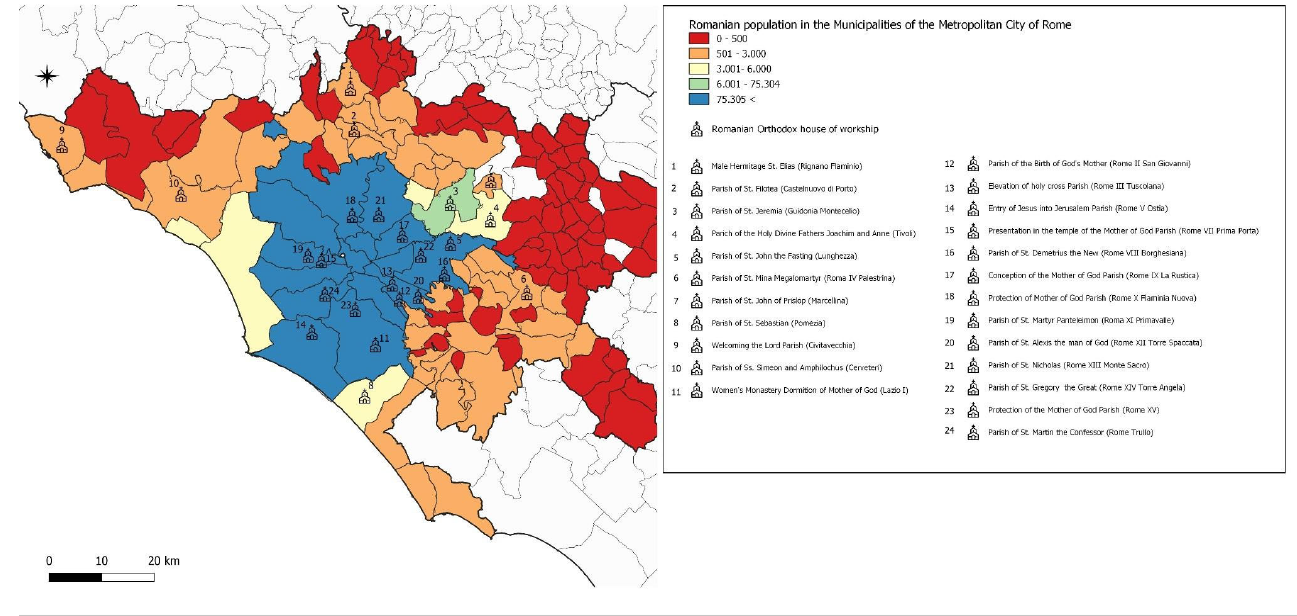
Figure 1. Distribution of the Romanian resident population in the municipalities of the Metropolitan City of Rome (1 January 2021) and mapping of Romanian Orthodox places of worship (churches, monasteries, and hermitages). Source: Cartographic elaboration by SO on data from the website of the Romanian Orthodox Diocese of